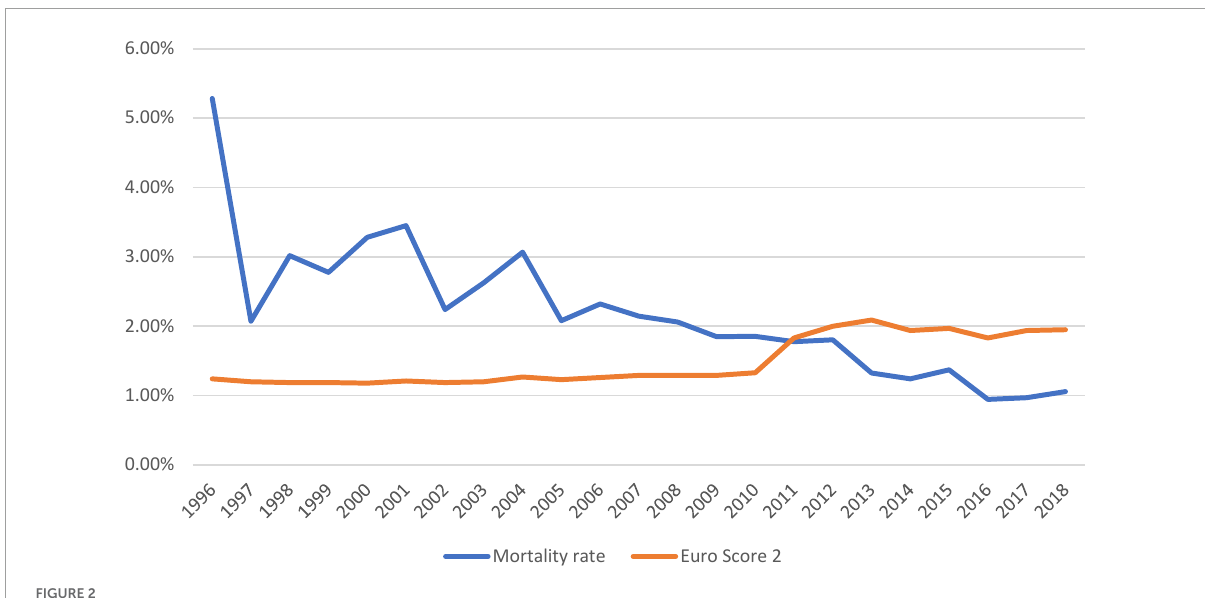
FIGURE2 Trend of observed and expected mortality rates in patients who underwent isolated surgical aortic valve replacement in the United Kingdom from 1996 to 2018.